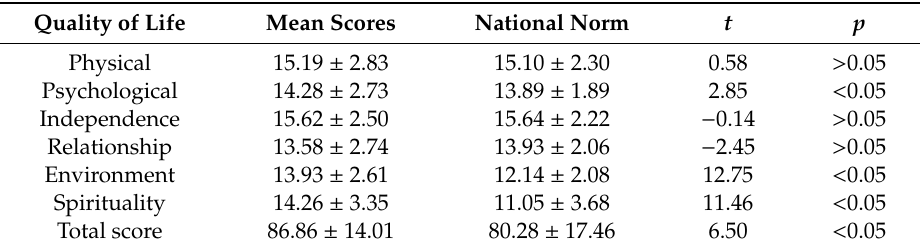
Table 1. Quality of life scores compared with national norm in China.